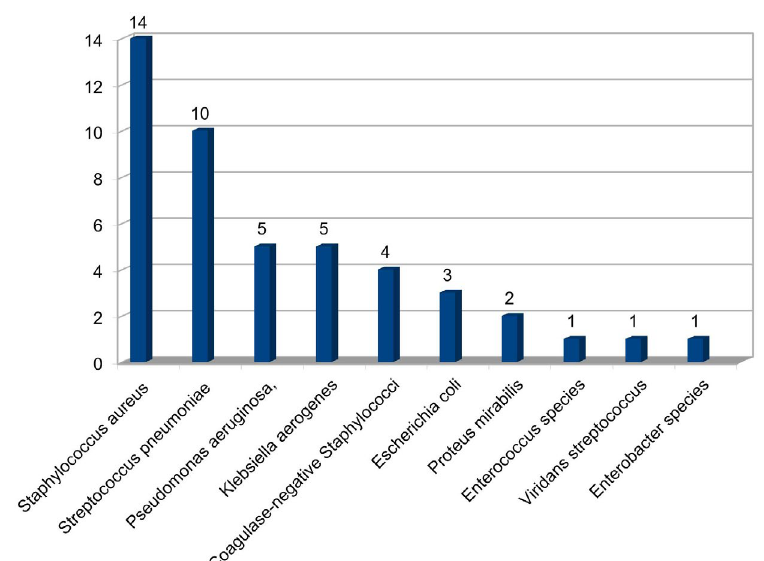
Fig. 1. Distribution of cases according to age and gender